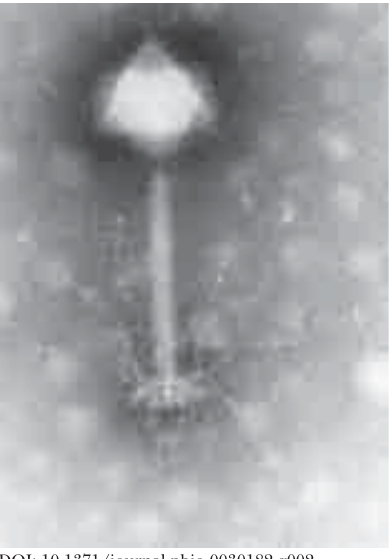
Figure 2. A Transmission Electron Microscope Image of the Synechococcus Phage S-PM2 (Image: Hans-Wolfgang